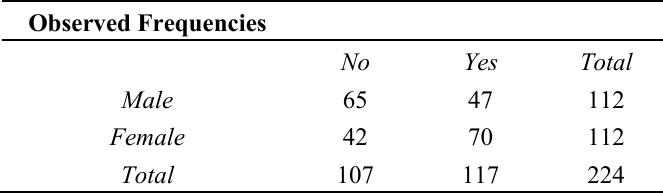
Table 6. Cross tabulation analysis between gender and frustration.